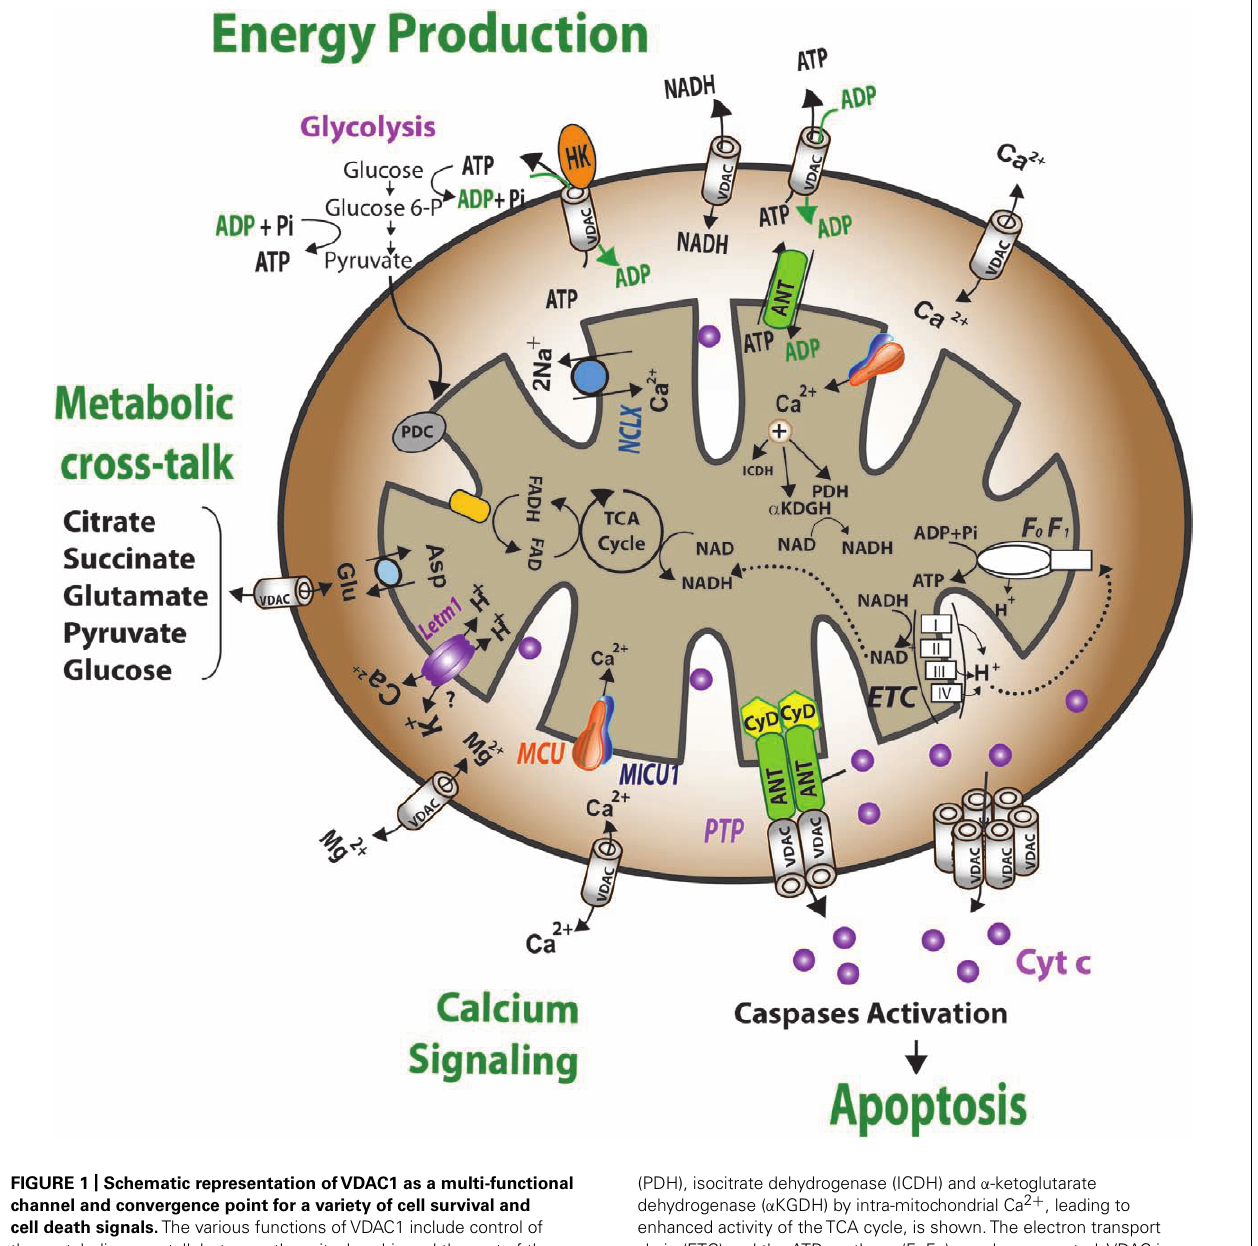
(PDH), isocitrate dehydrogenase (ICDH) and α -ketoglutarate dehydrogenase ( α KGDH) by intra-mitochondrial Ca 2 + , leading to enhanced activity of theTCA cycle, is shown.The electron transport chain (ETC) and the ATP synthase (F o F 1 ) are also presented.VDAC in the OMM is presented as a Ca 2 + channel. In the IMM, the uptake of Ca 2 + into the matrix is mediated by a Ca 2 + -selective transporter, the mitochondrial Ca 2 + uniporter (MCU), regulated by a calcium-sensing accessory subunit (MICU1). Ca 2 + efflux is mediated by NCLX, a Na + /Ca 2 + exchanger. High levels of matrix Ca 2 + accumulation trigger the opening of the PTP, a fast Ca 2 + release channel. Molecular fluxes are indicated by